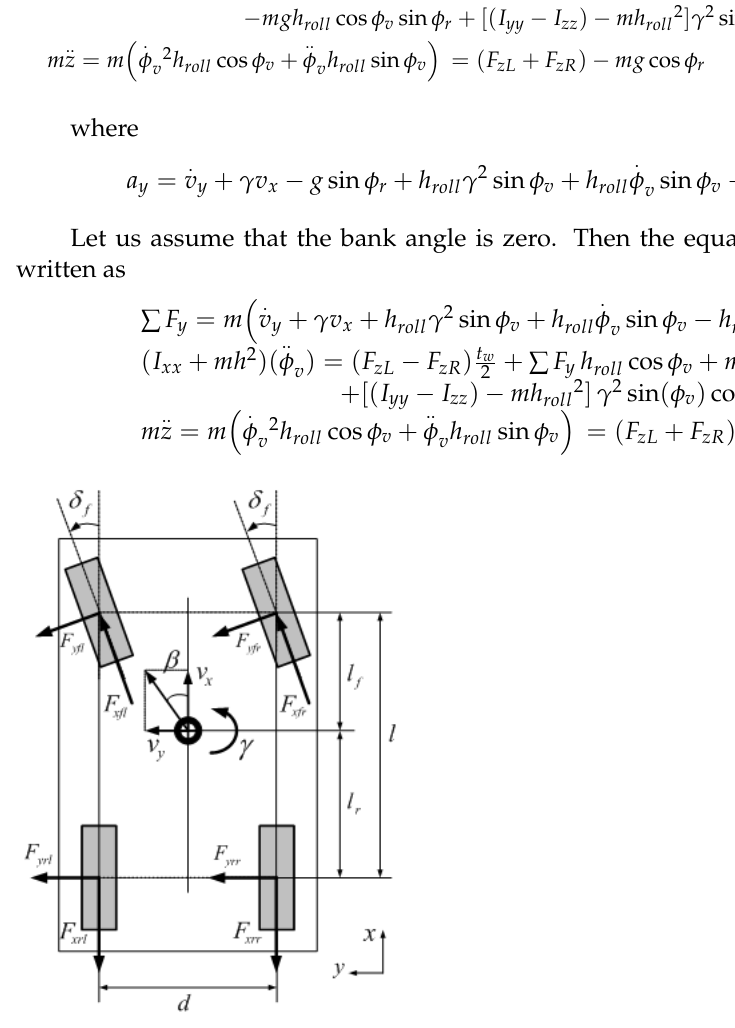
Figure 1. Planar model of vehicle dynamics.